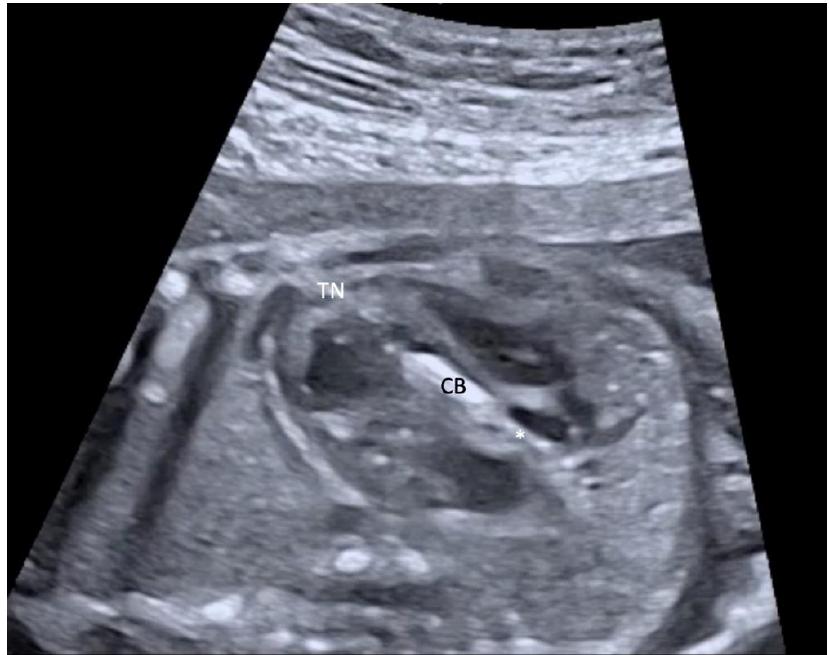
Figure 4. Left outflow tract view in a fetus at 26 + 1 weeks of gestation with severe aortic stenosis with a trocar needle (TN) placed in the left ventricle and the coronary balloon catheter (CB) placed over the aortic valve. The guide wire (asterisk) is positioned in the ascending aorta.